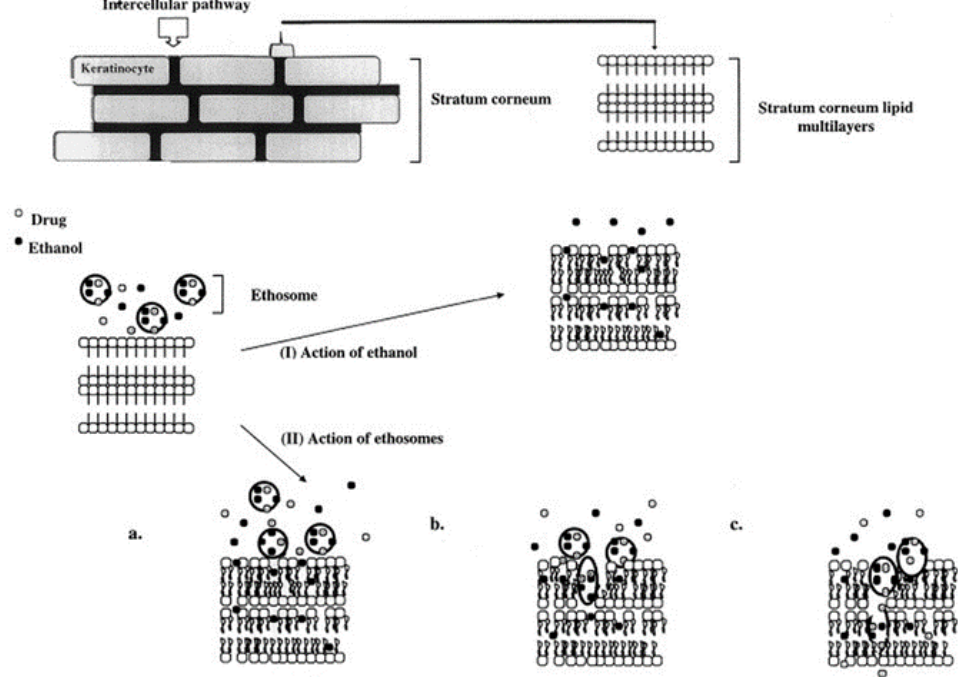
Figure 4. Proposed model for the mechanism of skin delivery from ethosomal systems containing phospholipids, ethanol and the drug. Reproduced from Reference [4] with permission.